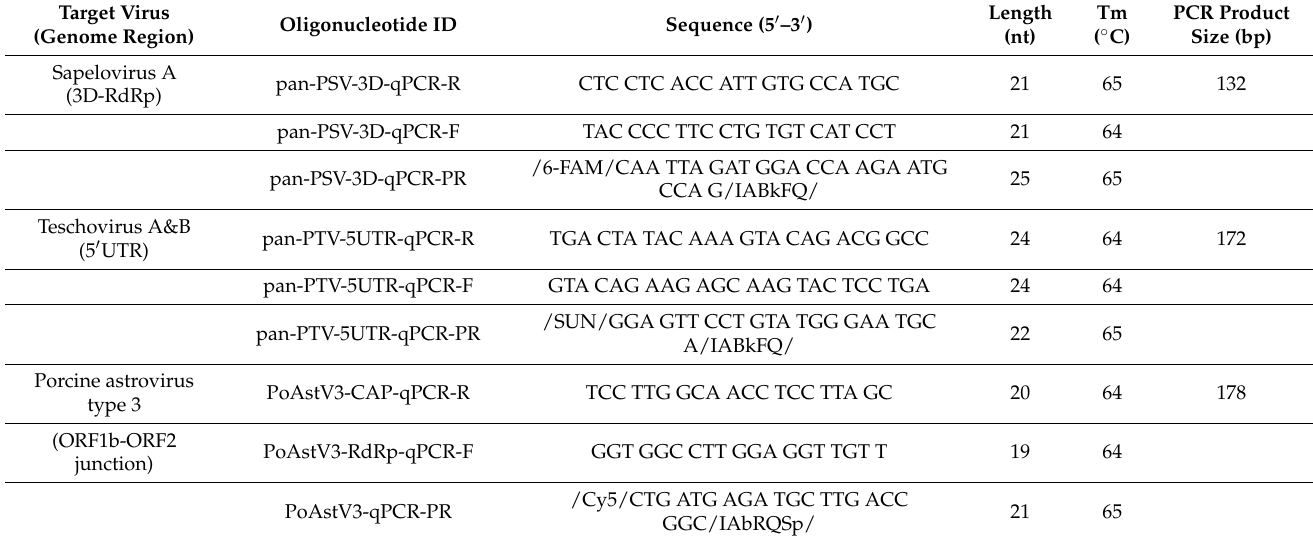
Table 1. List and characteristics of oligonucleotide primers and probes (with PR acronym) used for singleplex/triplex RT-qPCR assays in this study. F: forward, R: reverse, Tm: melting temperature. 6-FAM: 6-Carboxyfluorescein; SUN: a fluorophore with similar spectral characteristics to HEX and VIC dyes. Cy5: Cyanine 5/IABkFQ/3’ Iowa Black ® FQ quencher; /IAbRQSp/3’ Iowa Black ® RQ quencher.